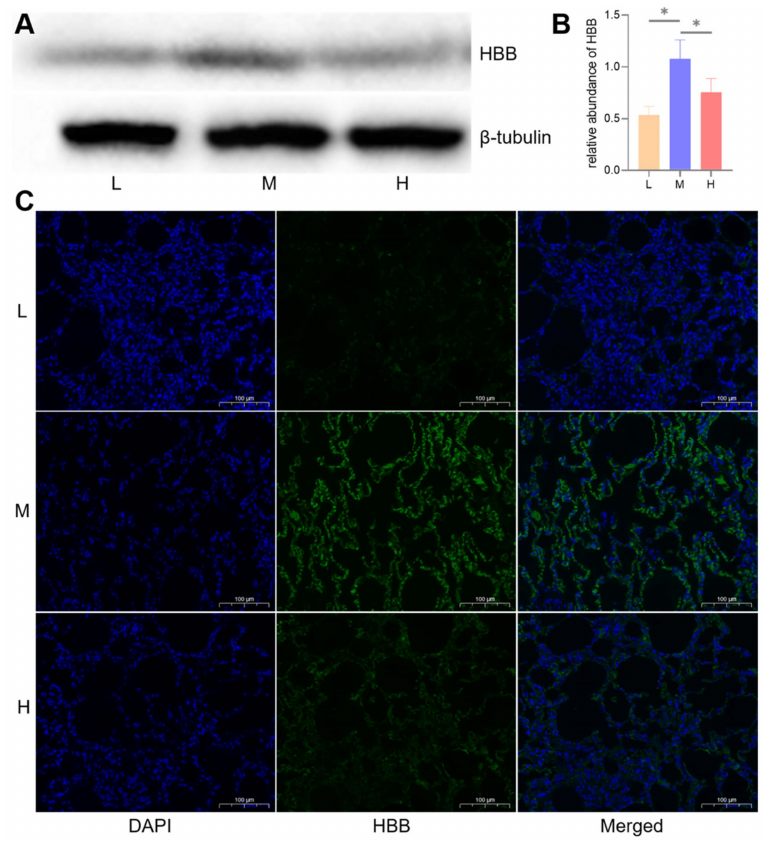
Figure 13. WB and immunofluorescence analysis of the key protein, HBB. Changes in the expression levels of HBB protein at low (L), middle (M), and high (H) altitudes, depicted by a WB ( A ), a histogram ( B ), and immunofluorescence ( C ), * indicates significant differences between different altitudes ( p <